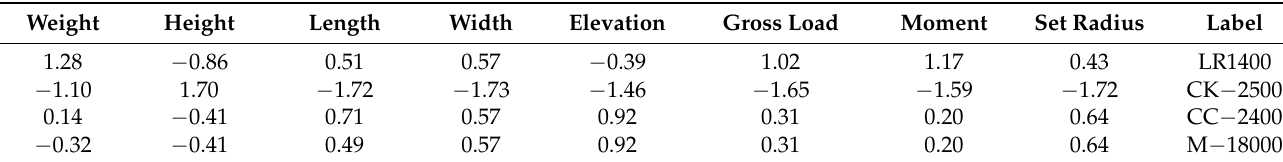
Table 2. Examples of normalized